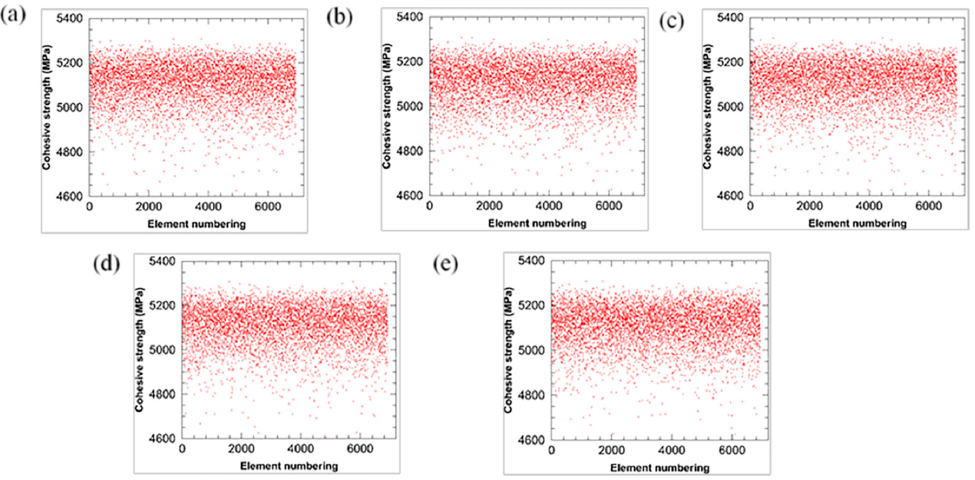
Figure 13. Weibull random fields of the NGL, ( a ) No. 1, ( b ) No. 2, ( c ) No. 3, ( d ) No. 4, and ( e ) No. 5.